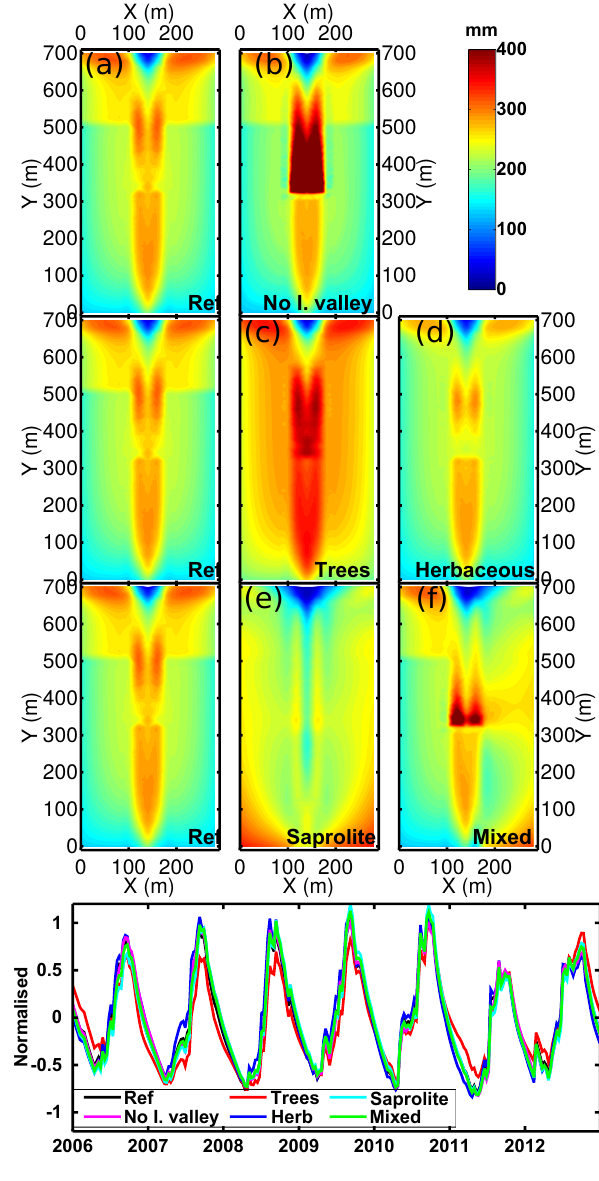
Figure 8. Simulated water storage changes: first mode of the EOF for all cases: upper panel: spatial patterns. Lower panel: temporal